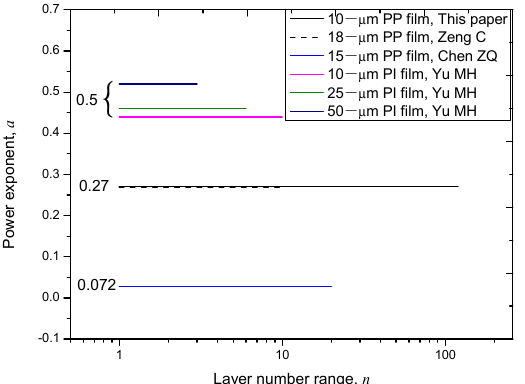
Figure 4. The value of power exponent, a , in a wide layer number range.